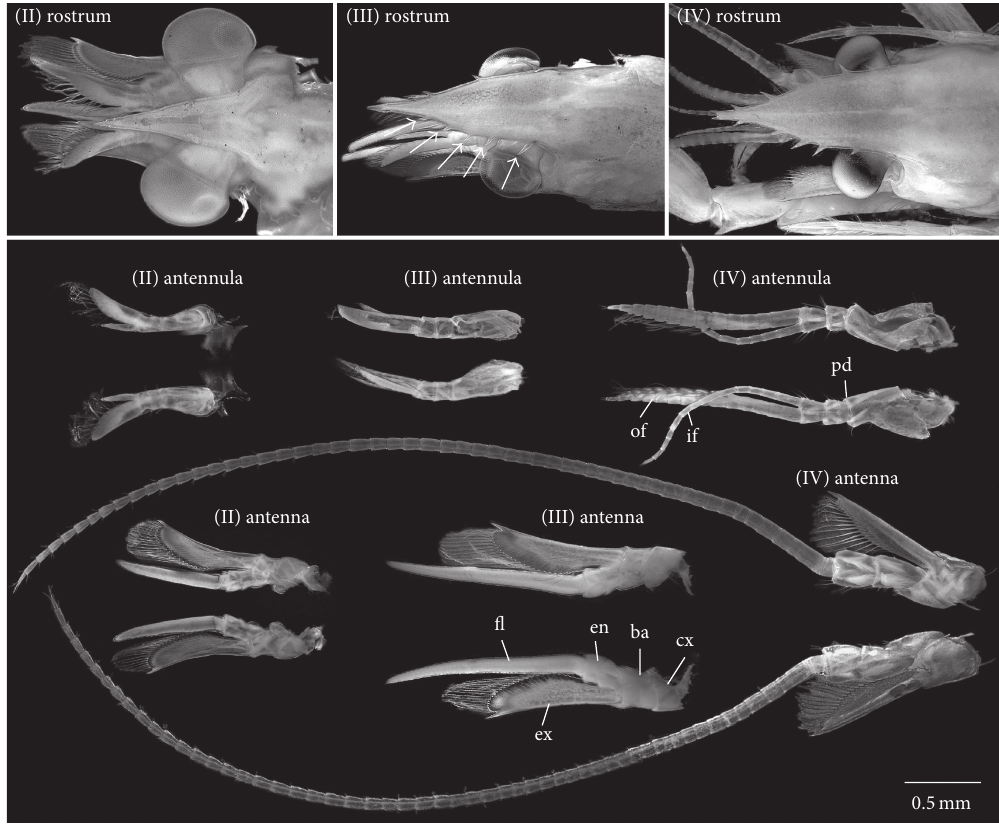
Figure 3: Anterior structures of larval stages (II) to (IV) of Homarus gammarus . Rostra not to scale; note the spines (marked by arrows) in stage (III). Antennula and antenna. Right appendage in anterior (upper row) and posterior (lower row), besides (II) antenna, which is a left one and flipped. Labeling only given in one instance due to the similarity of the structures throughout all stages. ba = basipod; cx = coxa; en = endopod; ex = exopod; fl = flagellum; if = inner flagellum; of = outer